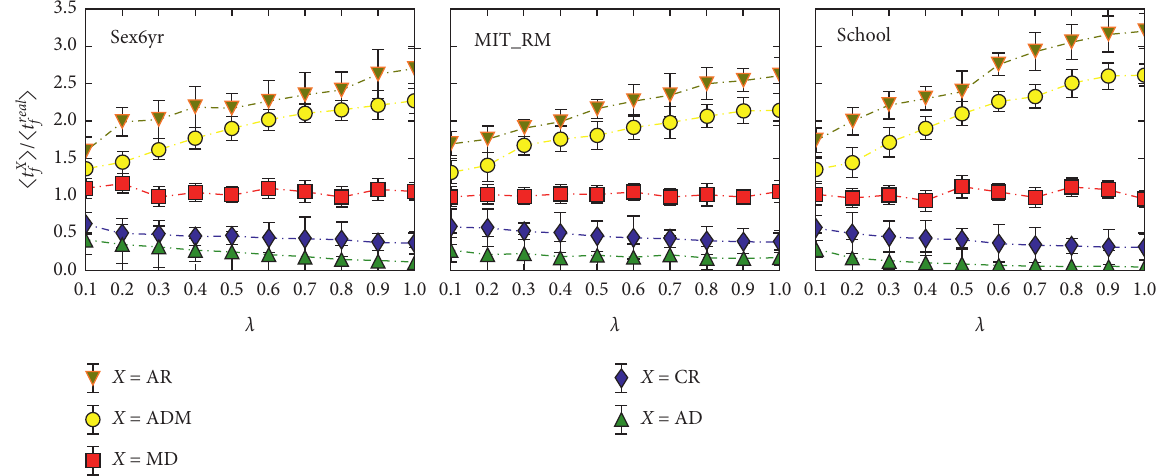
Figure 8: The ratio 〈 t X 〉 / 〈 t real 〉 of the average full prevalence time as a function of the infection rate λ in three empirical datasets, where f f X � AR , CR , AD , ADM , MD represents the agents randomized null models ( ▽ ), contacts randomized null models ( ◇ ), activity-driven models ( △ ), activity-driven models with memory (ˆx), and memory-driven models ( □ ), respectively. The simulations are performed on 10 3 realizations. The error bars here represent one binomial standard deviation from these averages with 95% confidence levels. All the models present the same critical spreading rate as the empirical counterparts.